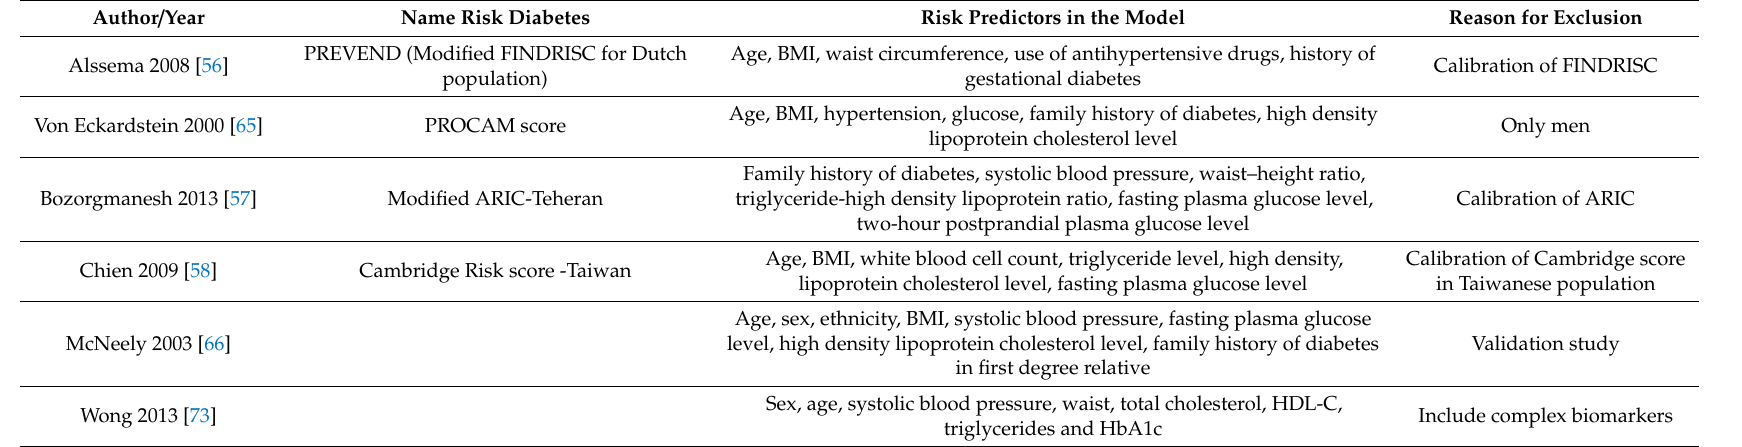
Table 2. Models excluded for predicting risk of incident type 2